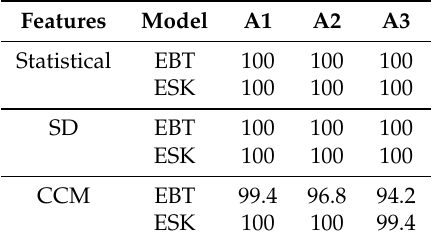
Table 2. Percent accuracy for each of features types and models calculated for each vibration